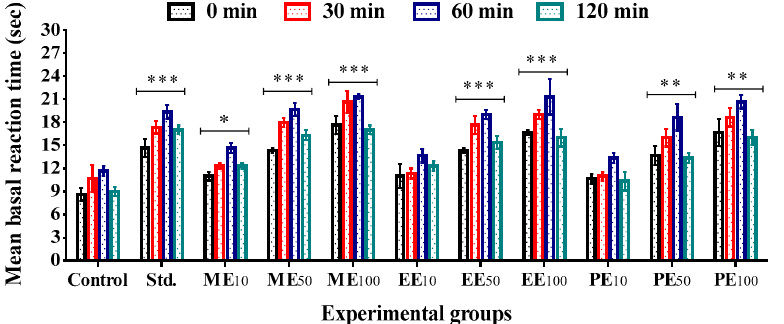
Figure 5. Mean basal reaction time of ester prodrugs of ketoprofen evaluated by hot plate method. Data was expressed as mean ± SEM, where n = 5. A value of *** p < 0.001, ** p < 0.01 and * p < 0.05 vs. control was considered significant.